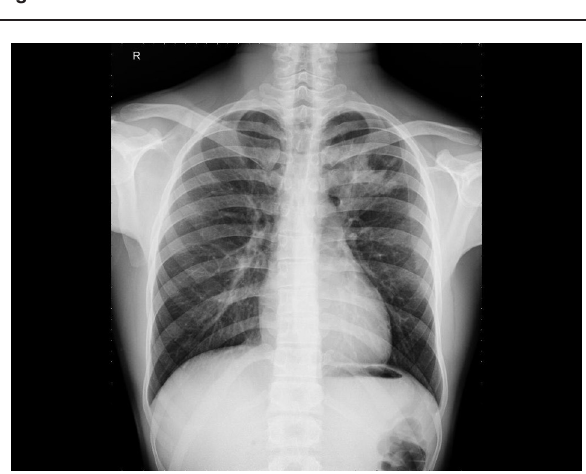
Chest radiograph at presentation.